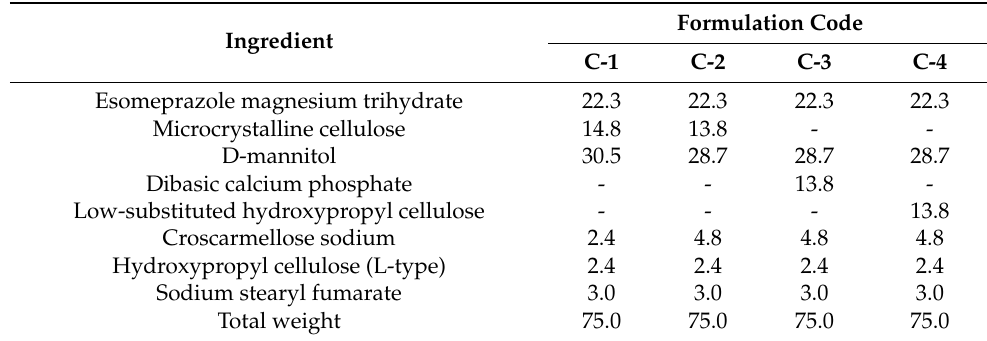
Table 1. Composition of EMP-loaded mini-tablet core formulas (Amount per capsule containing 10 mini tablets, unit: